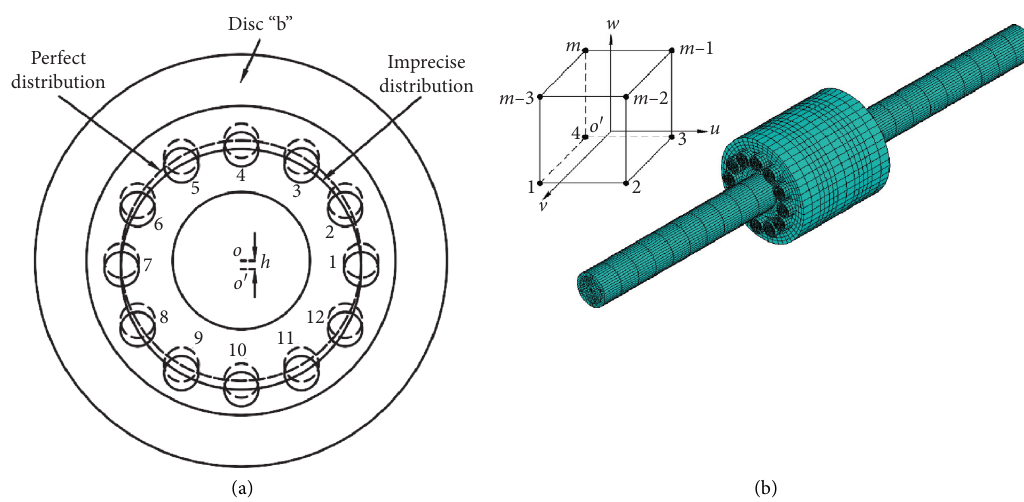
Figure 3: 3D model of bolt-disc rotor with the position error of bolt-holes. (a) Imprecise disc “b” and (b) imprecise bolt-disc rotor.